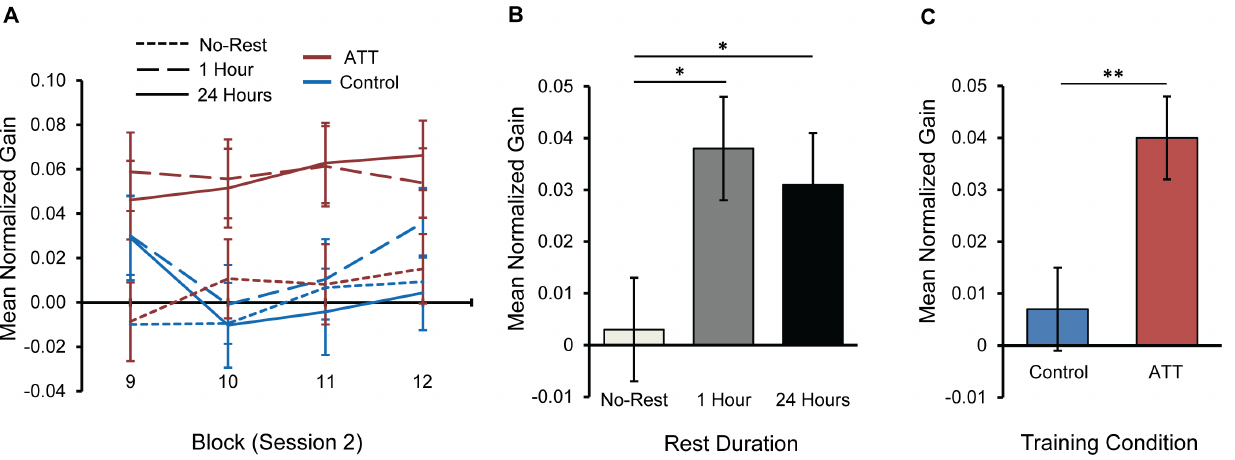
Figure 3. Delayed (offline, between-session) gains. Group means for mean delayed performance gains in Session 2, normalized to performance in the final block of Session 1. Displayed are (A) progression of mean delayed gains in Session 2 for all Rest Duration (No-Rest, 1 Hour, 24 Hours) by Training Condition (ATT, Control) groups; (B) main effect of Rest Duration (No-Rest, 1 Hour, 24 Hours), and (C) main effect of Training Condition (ATT, Control) on delayed performance gains. ATT=attend-threat training. Error bars signify 6 1 s.e.m. * p , 0.05, ** p , 0.01.